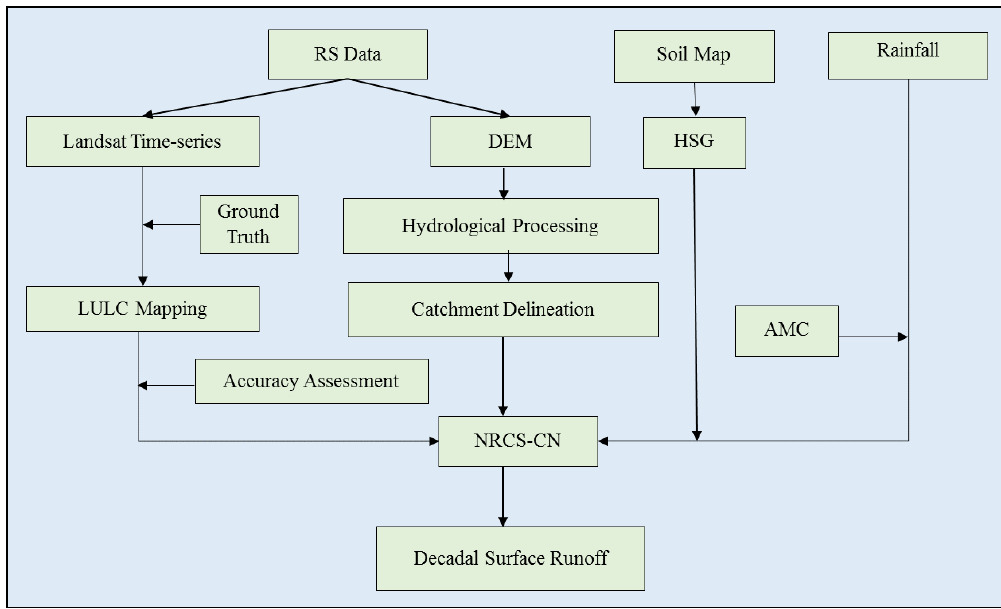
Figure 2. Methodological flow chart.